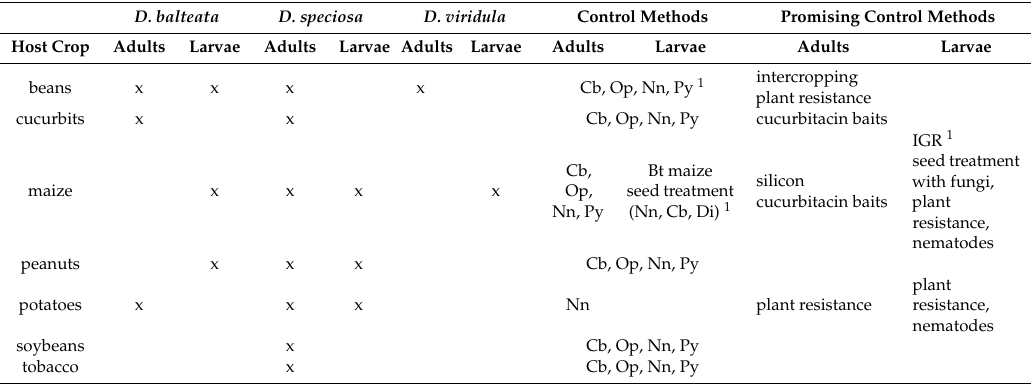
Table 1. Main crops attacked by the South American pest Diabrotica species, and current and potential control methods.